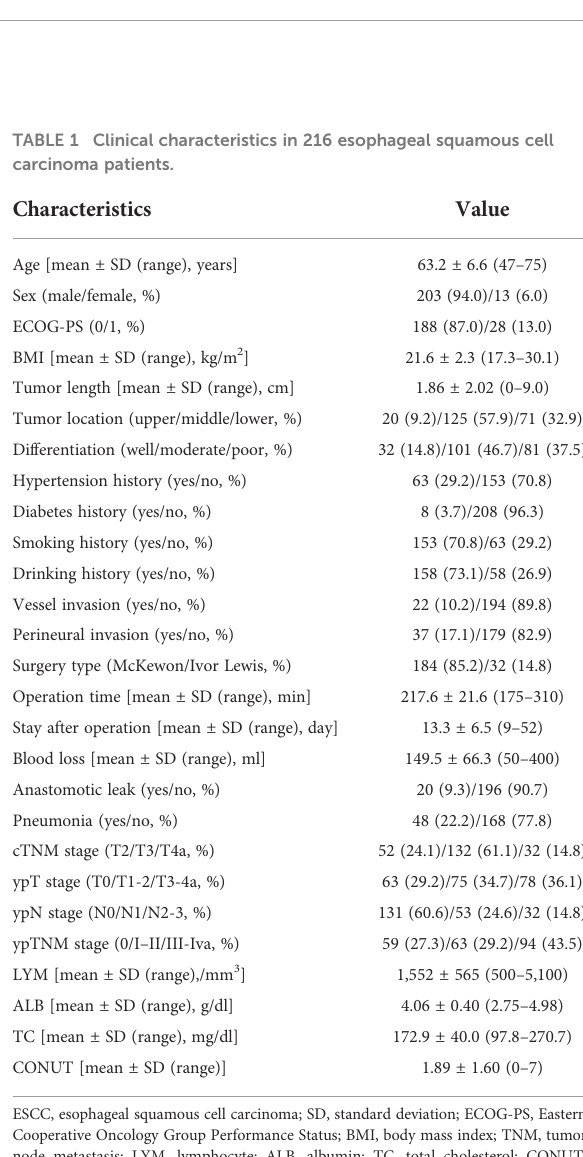
FIGURE 1 Flowchart for CONUT construction and risk strati fi cation. The CONUT is calculated as the sum of the albumin, lymphocyte, and total cholesterol.